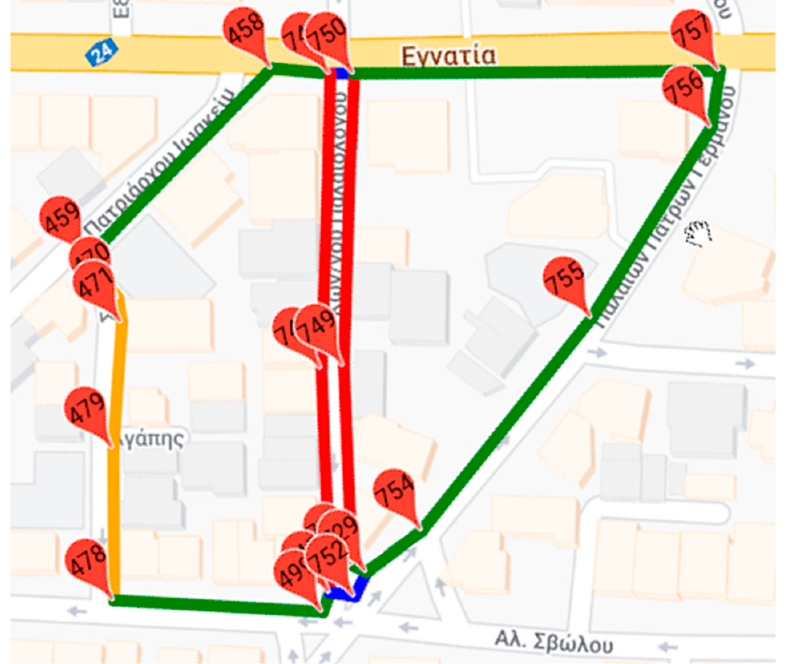
Figure 9. Use case IV graph dataset.